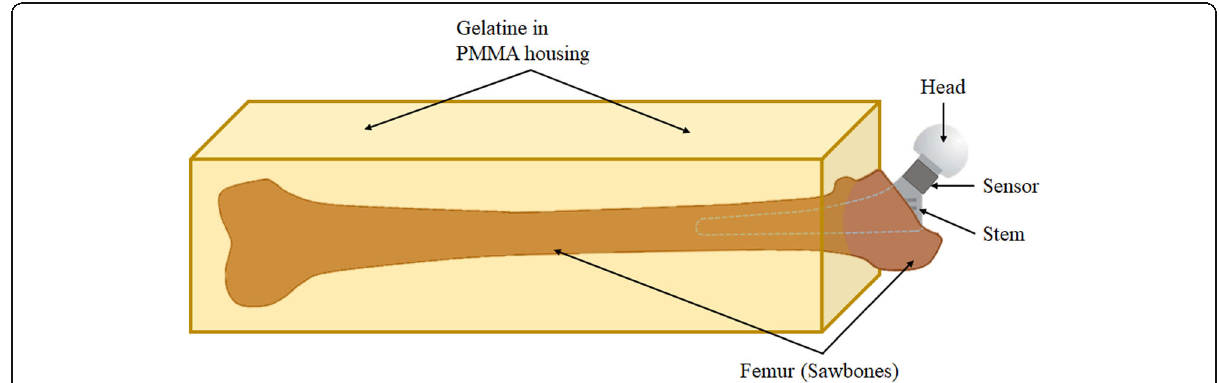
Fig. 3 Schematic illustration of embedded femur with implanted THA